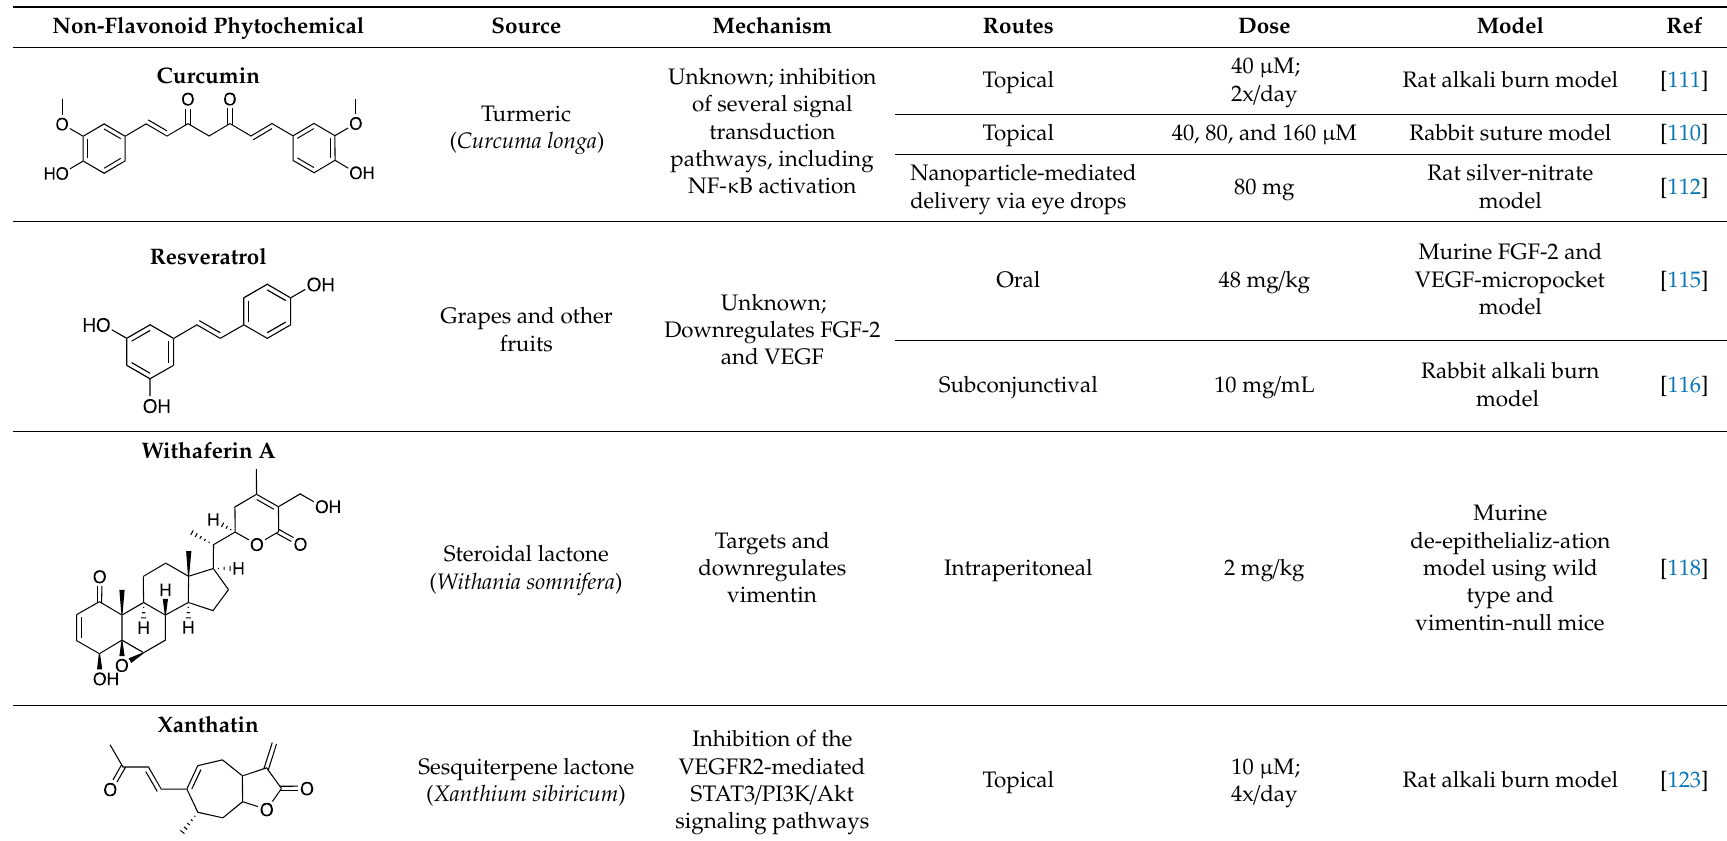
Table 5. Non-flavonoid phytochemicals tested in CoNV models.